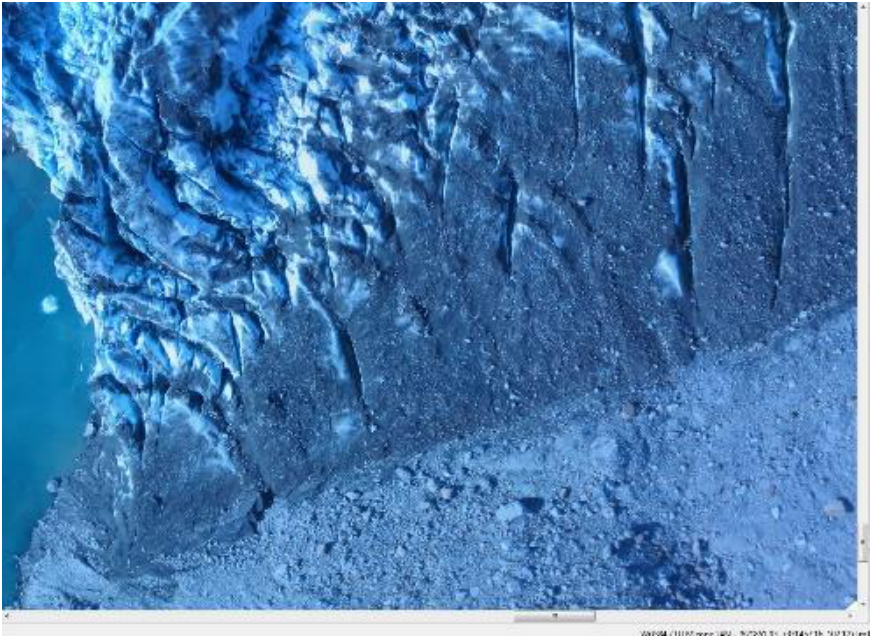
Figure 8. A typical photo using NIR camera Canon PowerShot ELPH 110 HS (NIR).